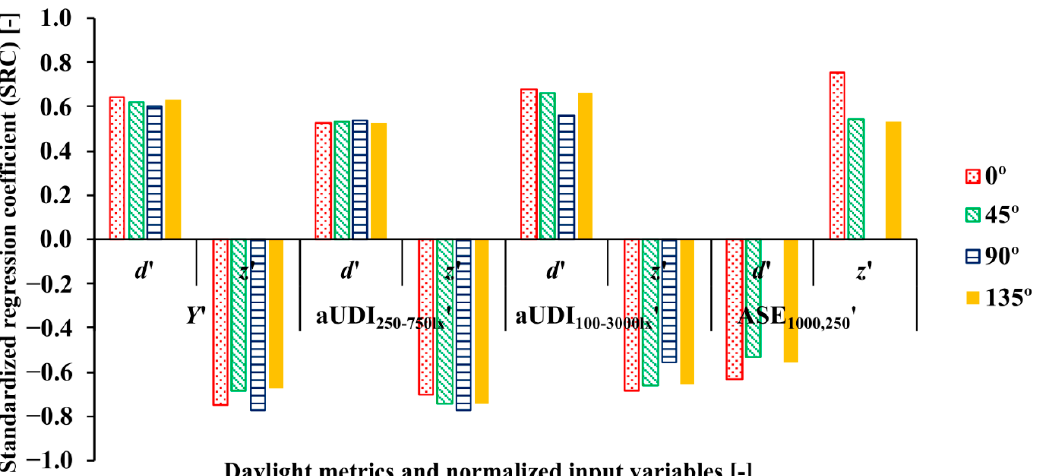
Figure 8. SRC values for d’ and z’ with observed daylight metrics and objective function Y at all orientations.